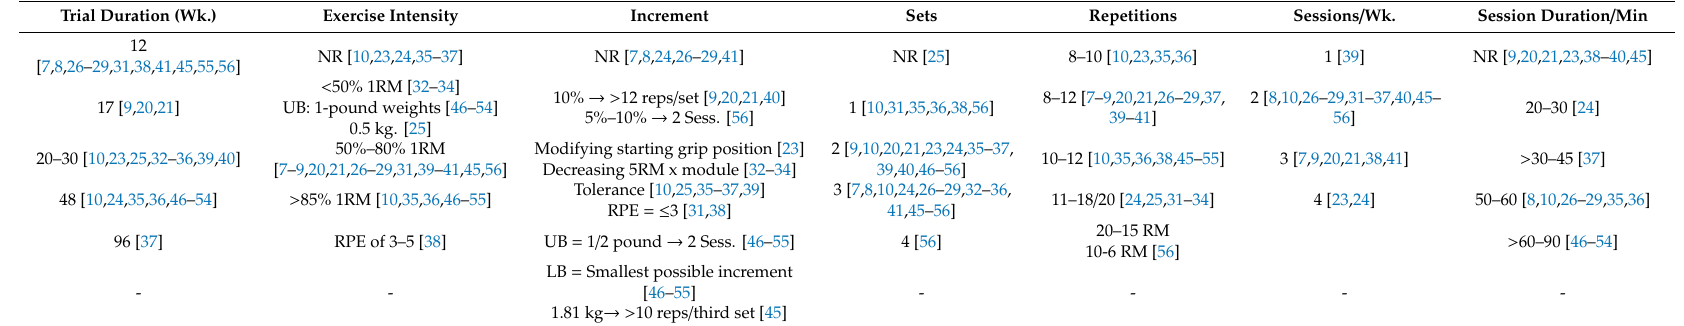
Table 8. Main characteristics of Exercise